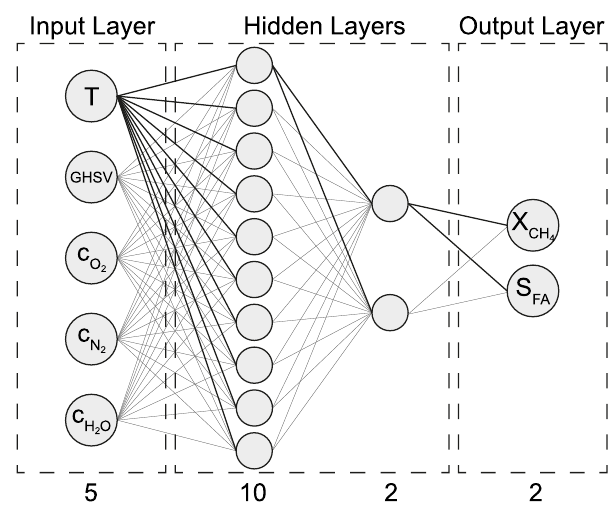
Scheme 1. Final neural network